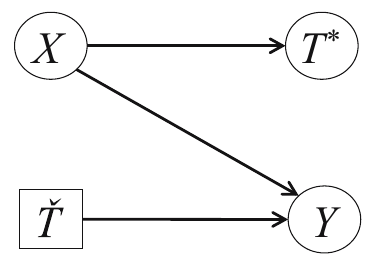
Figure 8: DAG representing su ffi cient covariate X : X